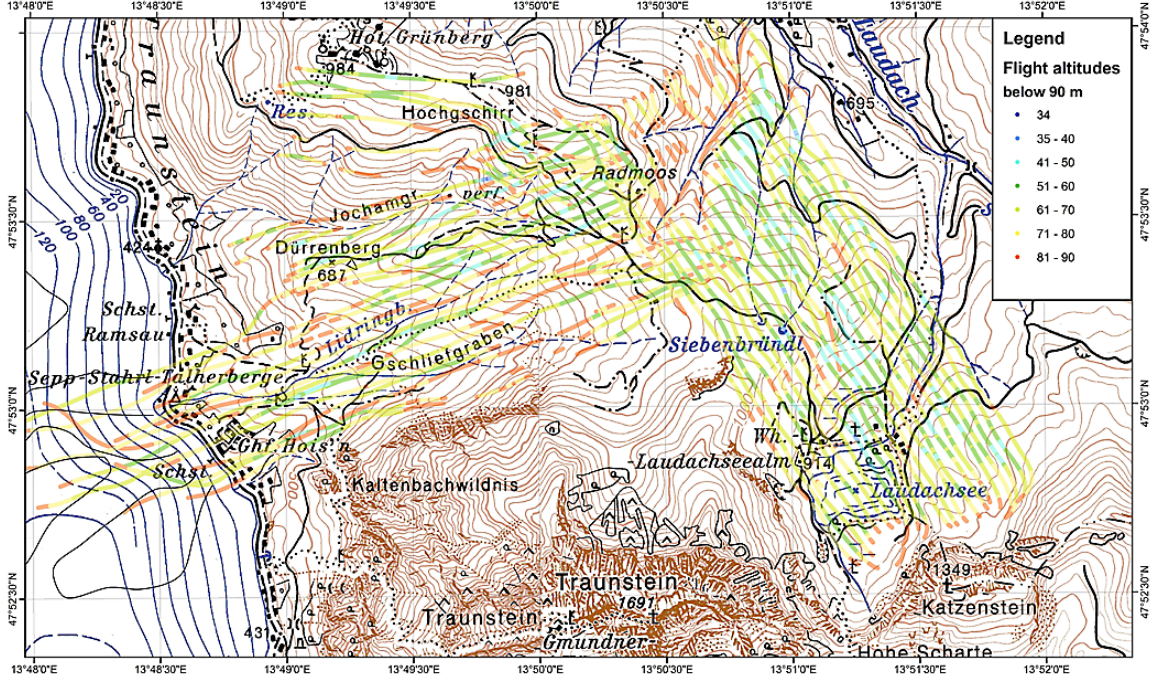
by a thick high-resistive sandstone layer (most probably a part of the Kalkgraben formation), topped by a medium re- sistive marl/claystone stratum (Altlengbach